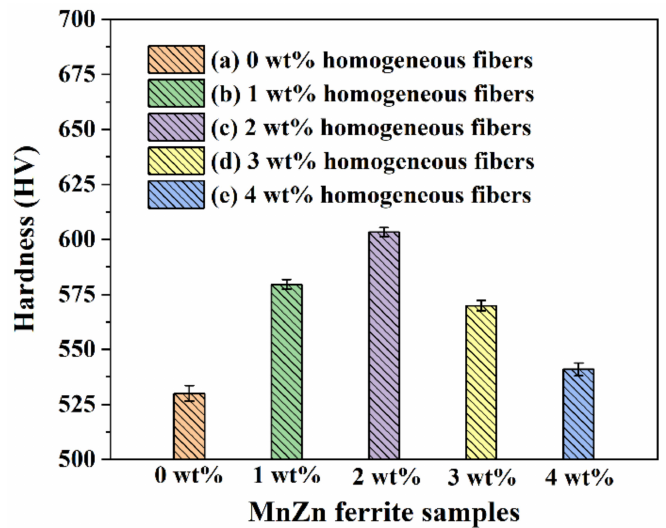
Figure 5. Vickers hardness of homogeneous-fiber-reinforced MnZn ferrite samples with different